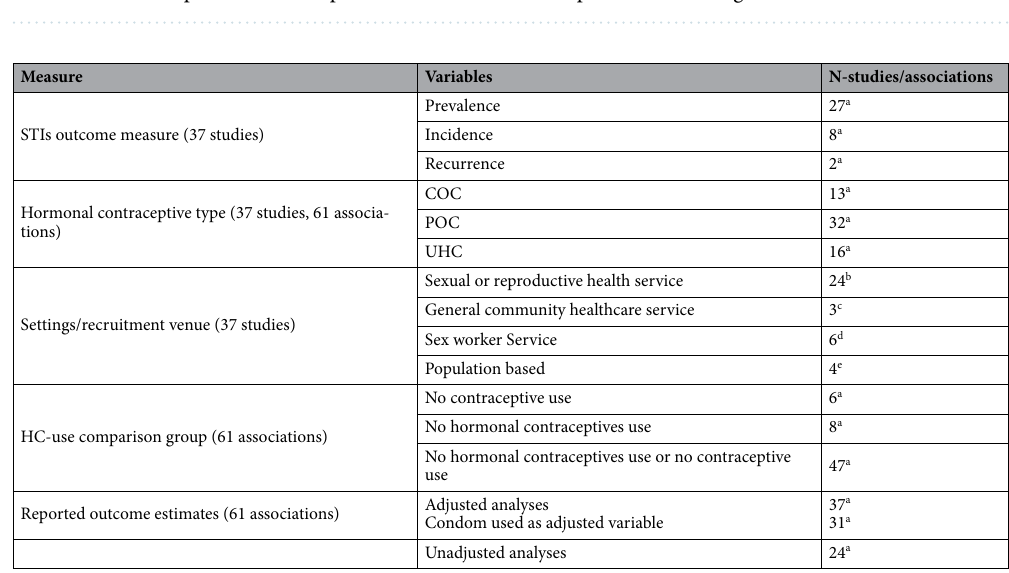
Table 1. Characteristics of prospective studies included in the systematic review. a All adjusted OR/RRs are reported by authors. b OR/RRs reported by authors. c Estimation recorded from Vodstrcil et al. 9 . d Raw data on the % using OC not available, on the basis of the odds ratios reported, the proportion of women using contraceptives were calculated to well exceed 10% g Woman-years, calculated by authors. LC Longitudinal cohort, PC Prospective cohort, CS Cross sectional, RCT Randomised controlled trial, RC Retrospective cohort, CC Case control. NHC No hormonal contraception, NC No contraception, POC progesterone-only containing methods of hormonal contraception, COC Combined oestrogen- and progesterone containing methods of hormonal contraception, UHC Unspecified hormonal contraception, TL Tubal ligation.